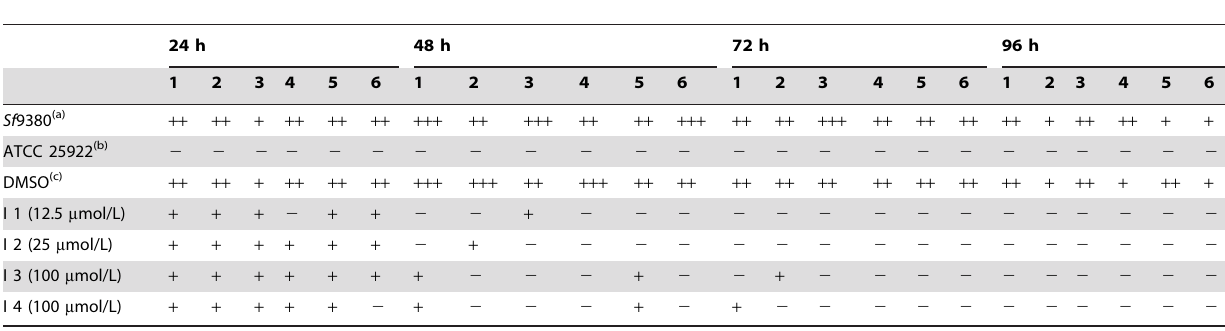
A Mouse Sereny test shows the virulence of S. flexneri Sf 9380. Mice inoculated with 1 6 10 8 CFUs display severe keratoconjunctivitis without purulence 24 hours post- infection, developed keratoconjunctivitis with purulence after 48 hours, and sustained the infection for 96 hours. Sf 9380 cultured with a serial dilution of potential PhoQ inhibitors was inoculated into mice, at 1 6 10 8 CFUs per eye. The degree of keratoconjunctival inflammation in each of the six mice infected with Sf 9380, ATCC 25922, DMSO, and Sf 9380 pre-treated with different concentrations